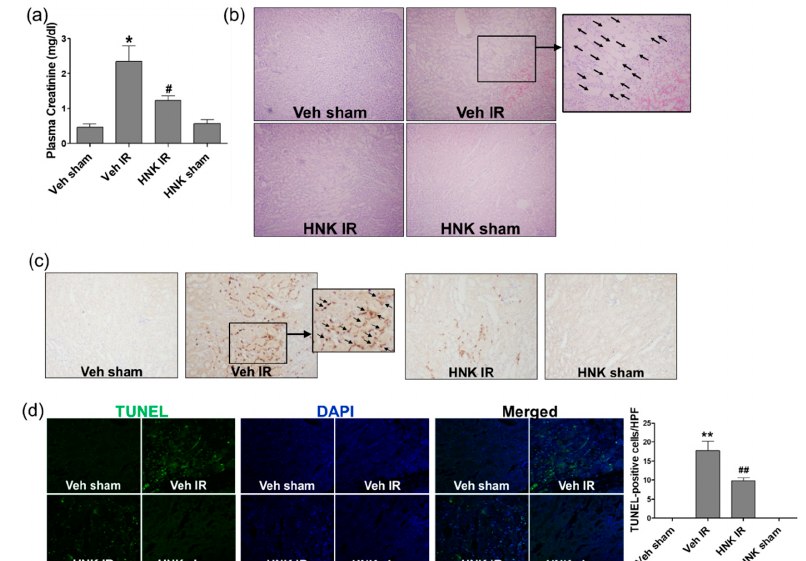
Figure 6. Honokiol attenuates the increase in plasma creatinine, tubular cell death and neutrophil infiltration induced by renal ischemia ‐ reperfusion (IR) in mice. C57BL/6 mice were subjected to 25 min of bilateral renal ischemia. Honokiol (1 mg/kg) or vehicle was injected twice, 1 h prior to ischemia and 4 h after reperfusion. The blood and kidney tissues were collected at 24 h of reperfusion. ( a ) Plasma creatinine levels were measured to assess the degree of kidney injury. ( b ) Representative images of H&E staining of renal sections to evaluate tubular pathology. Arrows indicate necrotic area. ( c ) Representative images of polymorphonuclear leukocytes (PMN) staining of renal sections to evaluate neutrophil infiltration. ( d ) Representative images of terminal deoxynucleotidyl transferase dUTP nick end labeling (TUNEL) staining of renal sections to evaluate tubular apoptosis; TUNEL (green) merged with DAPI (blue). Values are expressed as the means ± S.E.M. of 4–8 mice from each group. * p < 0.05, ** p < 0.01 significant compared with Veh sham. # p < 0.05, ## p < 0.01 significant compared with Veh IR.